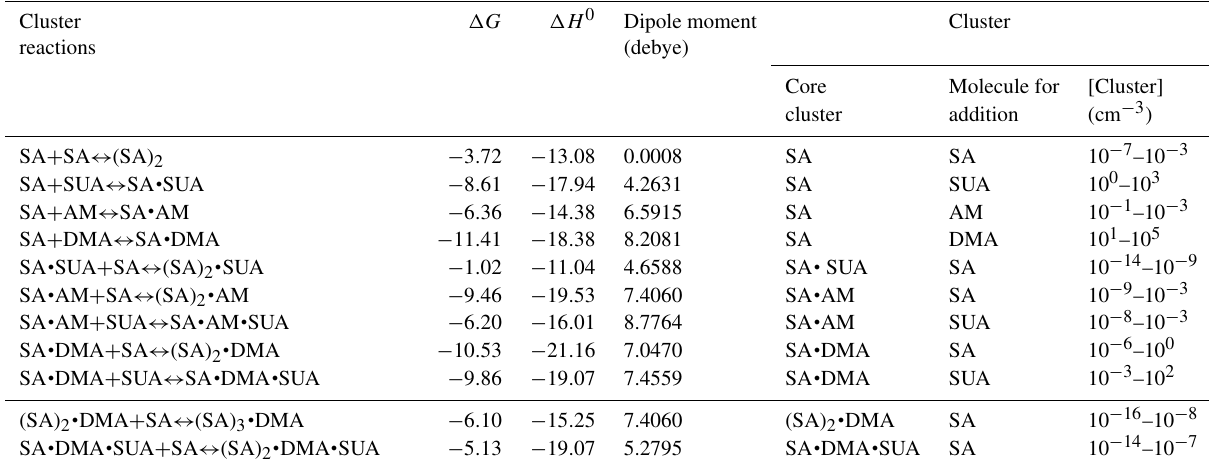
Table 6. Gibbs free energy ( (cid:49)G , kcalmol − 1 ), interaction energy ( (cid:49)H 0 , kcalmol − 1 ), and cluster concentration at equilibrium for basic clustering reactions. The right-hand side of clustering reactions are the product clusters in Eq. (7), and the core clusters and addition molecules in Eq. (7) are listed here as